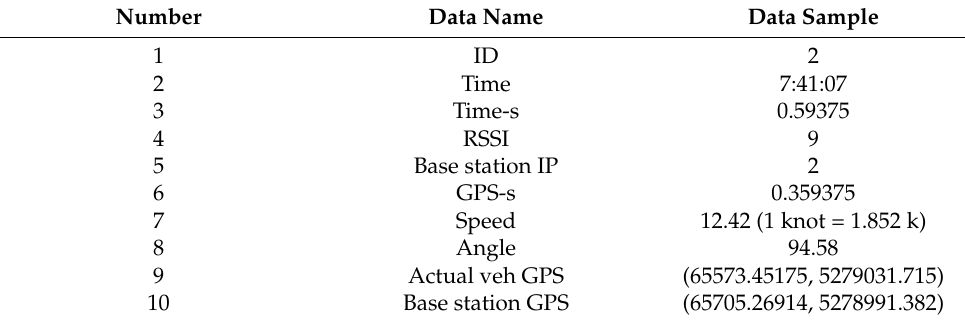
Table 5. Integration of data fields.